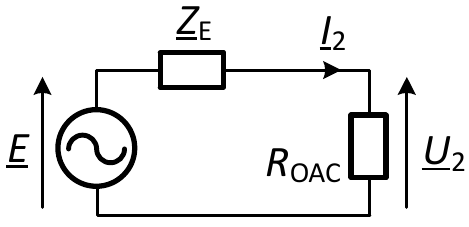
Figure 4. Thevenin’s equivalent of MCR circuit.